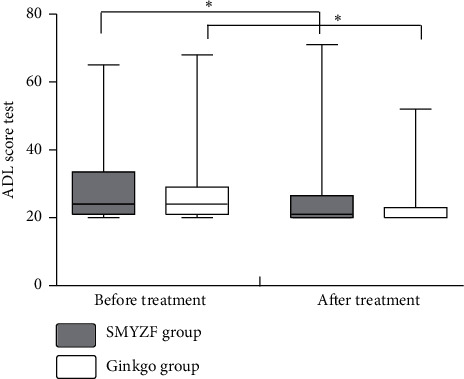
Comparison of ADL scores in the 2 groups. Note: ∗significant effect (P < 0.05).